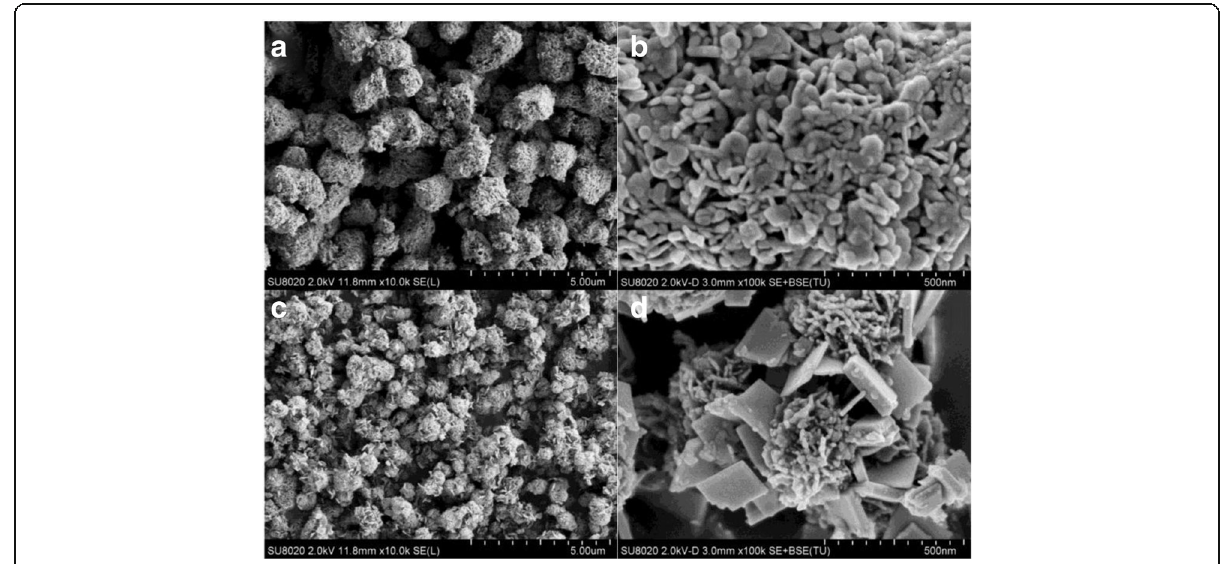
Fig. 2 SEM images of BiOCl ( a , b ) and Fe/BiOCl (0.25) ( c , d )